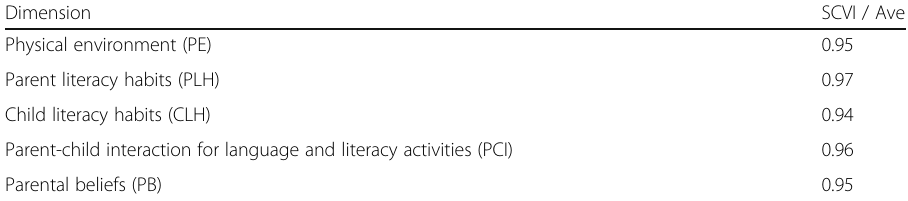
Table 6 Scale Level Content Validity Index (SCVI/Ave) for the five dimensions Dimension SCVI /